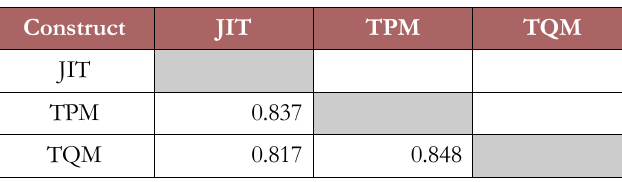
Table 5. Discriminant Validity: Heterotrait-Monotrait Ratio Statistics